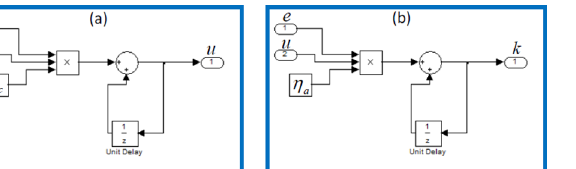
Fig 15. Implementation of update rules of (a) control optimizer(Eq 7) and (b) adaptationoptimizer(Eq 11) in Simulink.